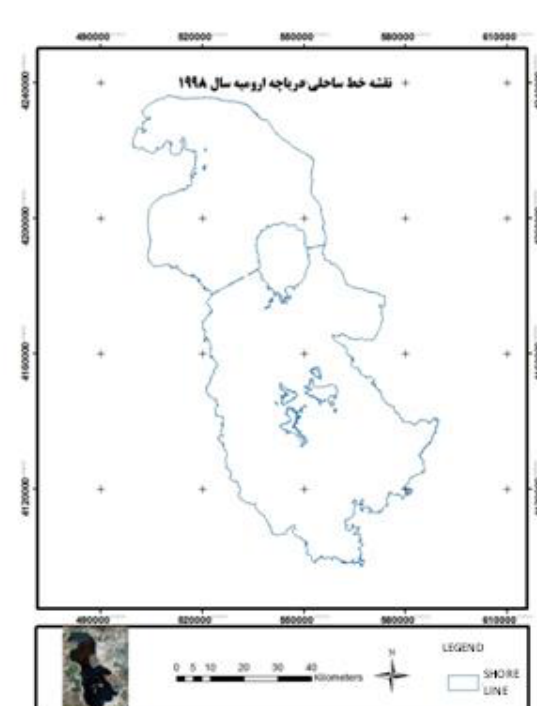
Figure 8: Urmia lake shoreline in 1976